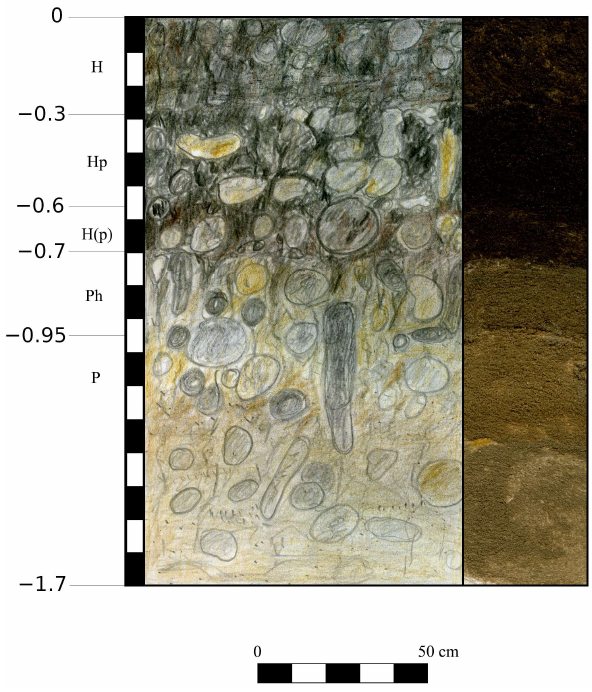
Figure 8. Kamyane-Zavallia 1. Soil-section 1. Captions: see Supplementary Table S3. Left column: soil horizons’ indices, dotted lines indicate changes of horizons; central column: schematic drawing; right column: photos of actual soil textures from respective horizons of the section, taken afield by gluing a respective sample to a sheet of paper. Elaboration—ZM.